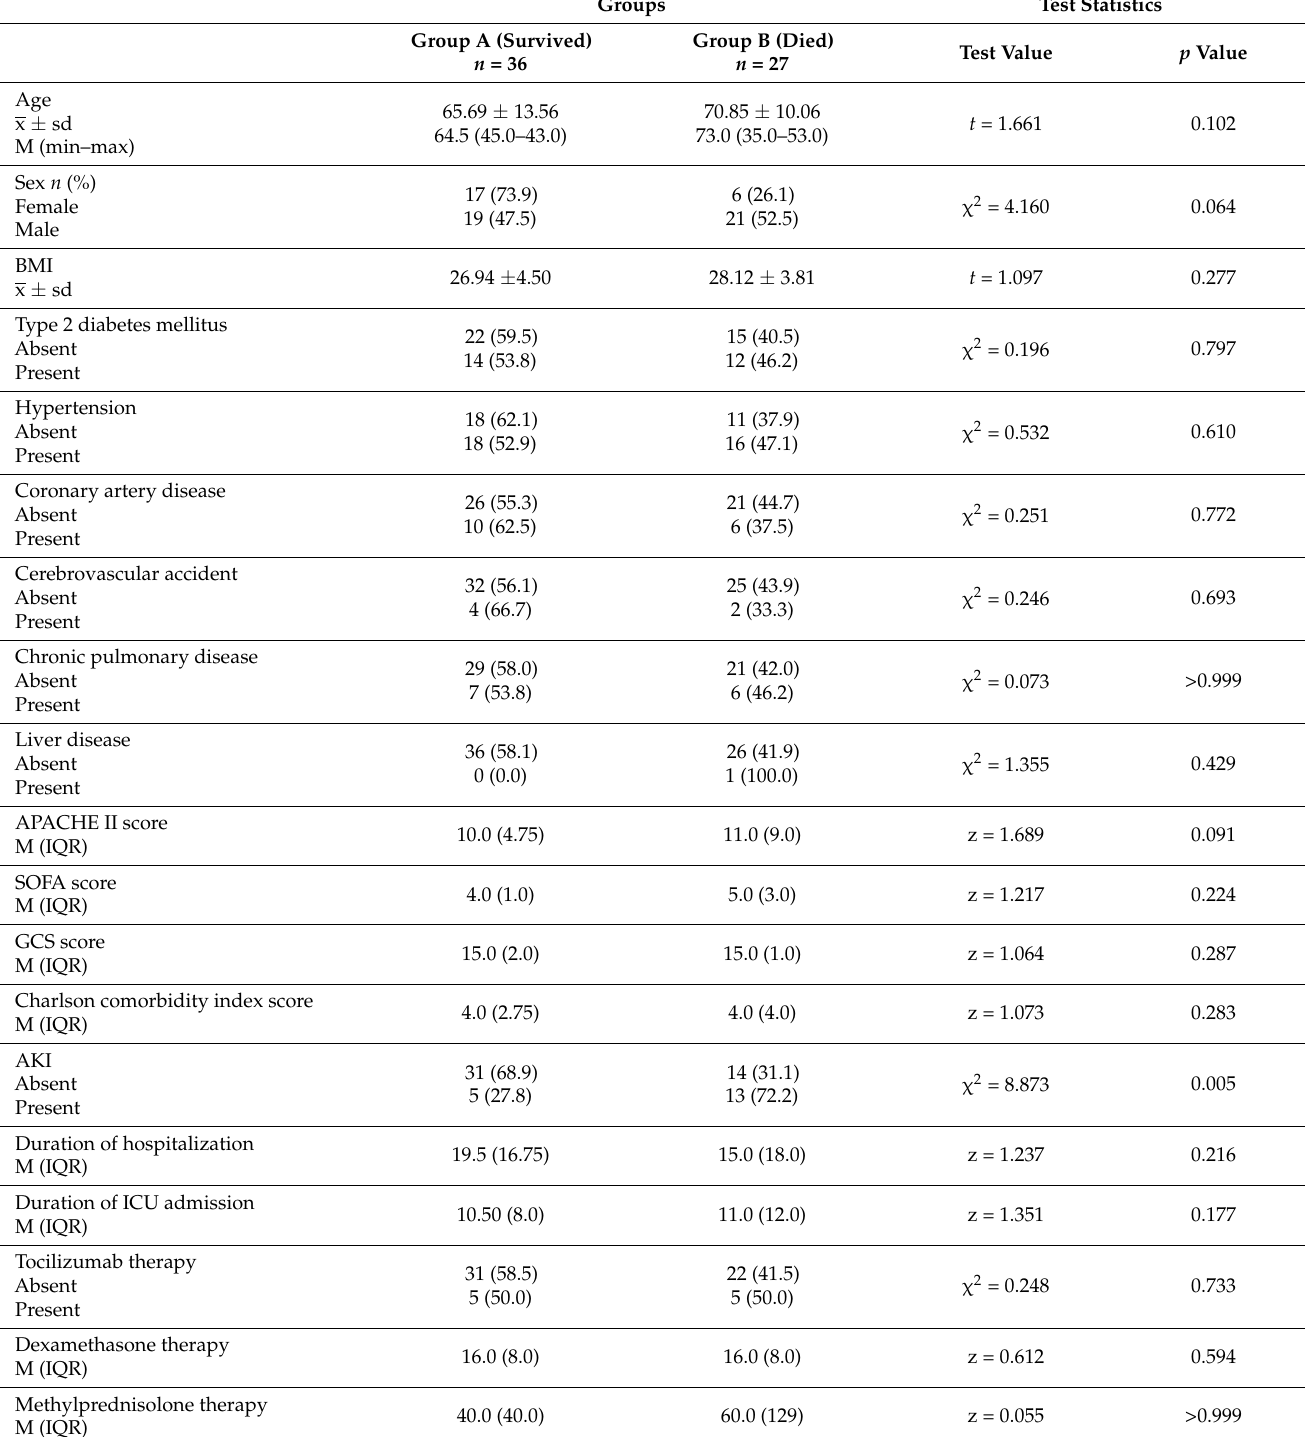
Table 1. Comparison of demographic and clinical parameters among the groups.